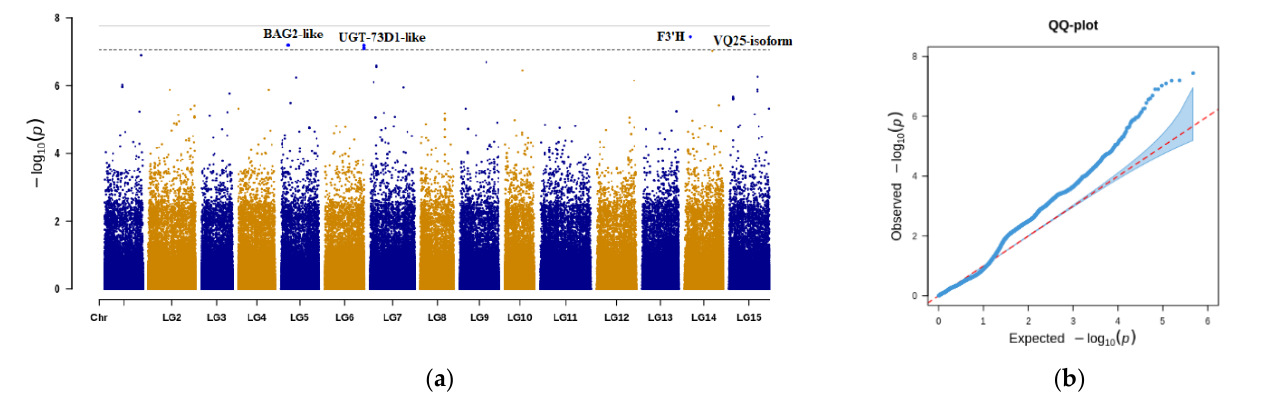
Figure 3. Genome-wide association study analysis of SRFC in 300 sweet potato accessions. ( a ) Manhattan plots of SNPs association for SRFC. ( b ) Quantile–quantile plots of expected and observed − log 10 ( p ) values at an FDR cut-off ≤ 0.05. The gray areas are the 95% confidence intervals under the null hypothesis of no association between the SNP and the trait. The red line is the expected line under the null distribution. The blue points are the observed distribution. Table 2. Summary of SNPs above the significance